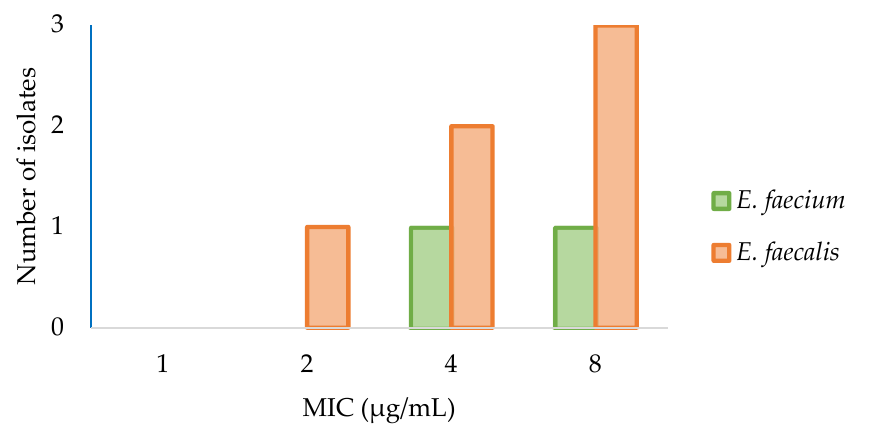
Figure 3. Distribution of linezolid MIC values among strains of E. faecalis ( n = 6) and E. faecium ( n = 2) carrying the optrA gene using the EUVENC microdilution plates.